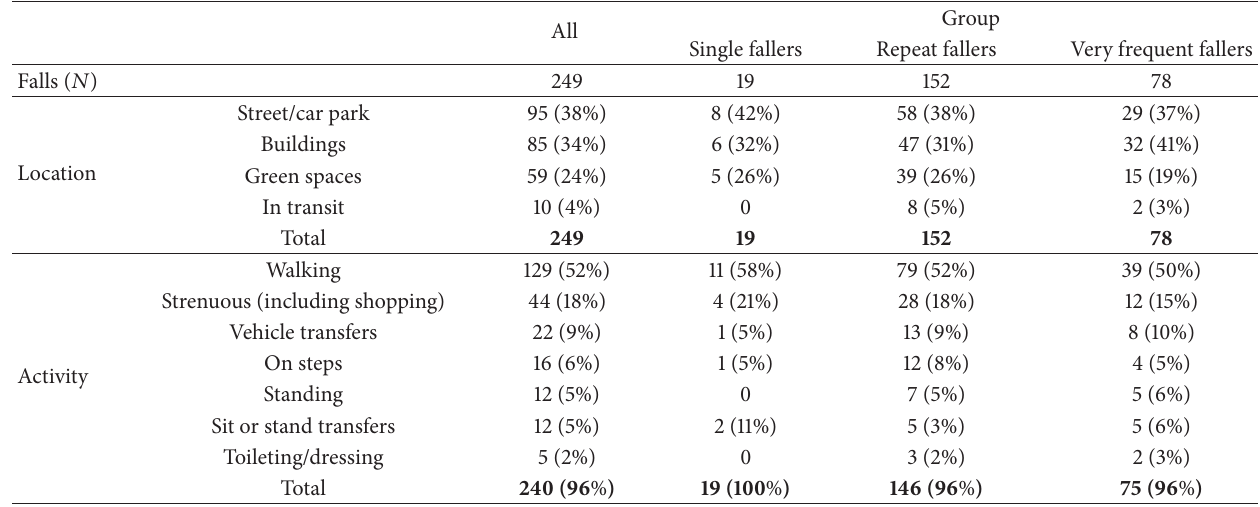
Table 2: Falls beyond home: locations and fall-related activity ( 𝑁 = 249